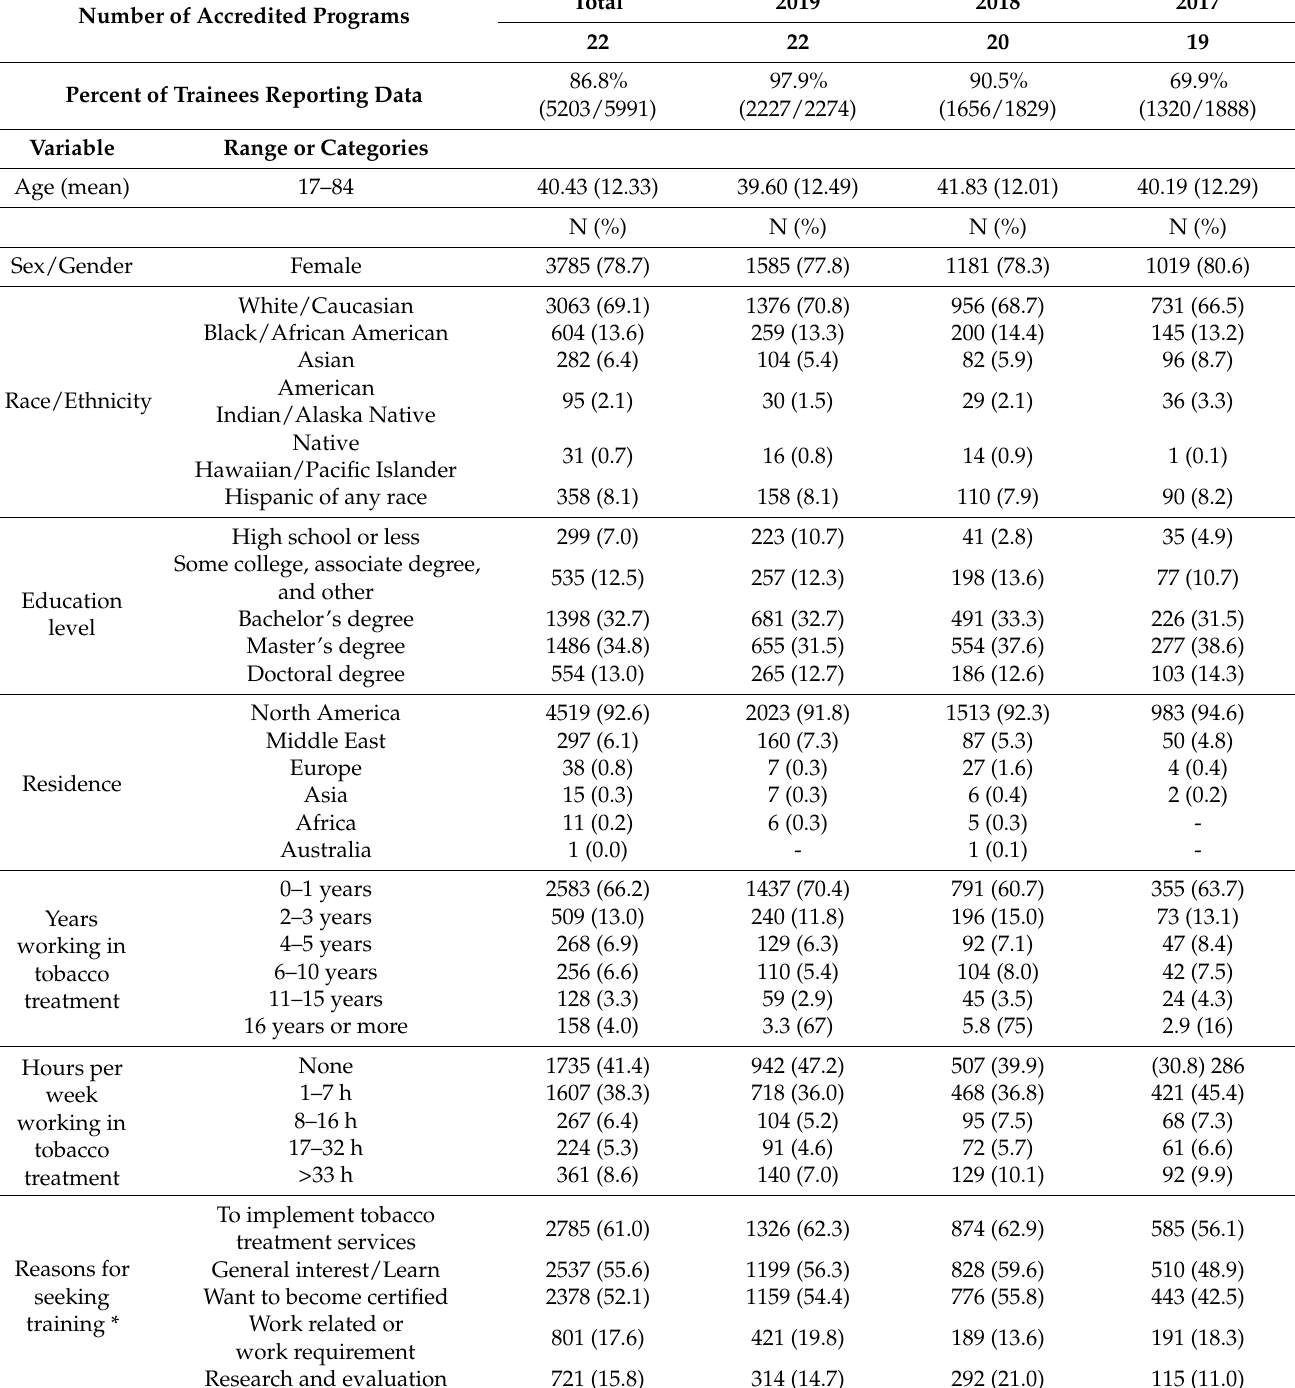
Table 1. Characteristics of Training Program